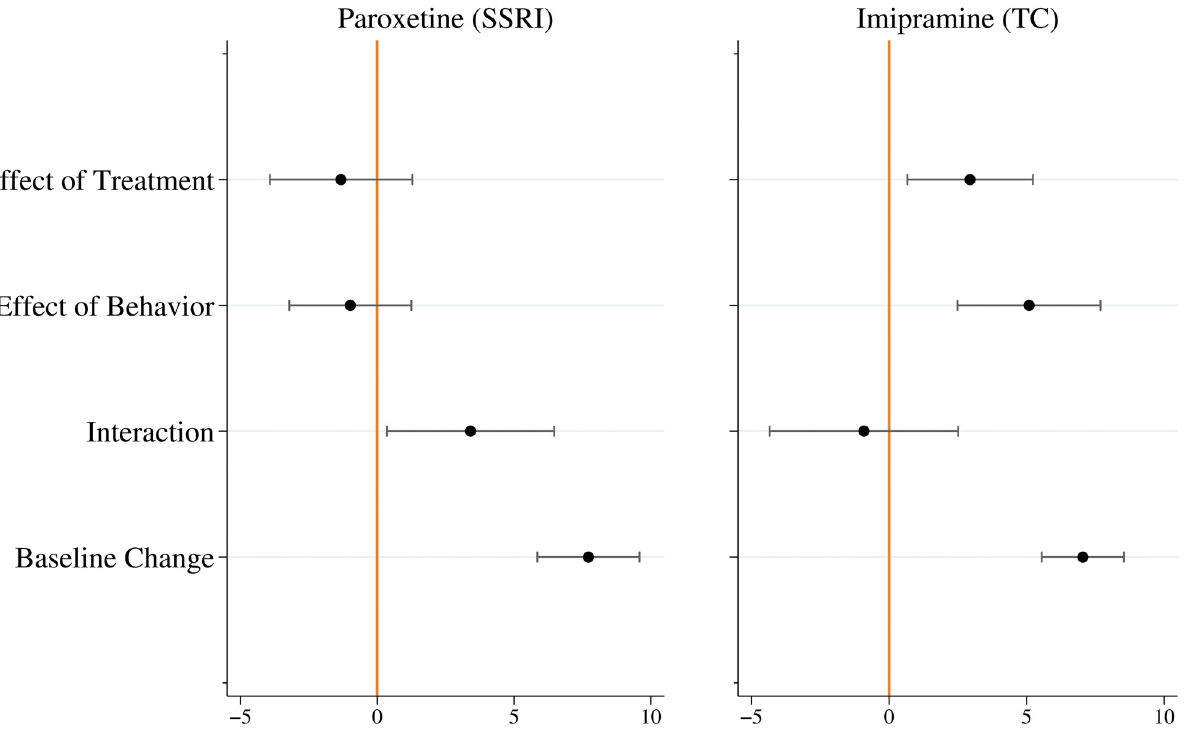
Fig 3. Behavior matters for both the SSRI and TC, but in different ways. The panels show the effect size (change in HDRS score) as point estimates (dots) and 95% confidence intervals centered at the point estimate constructed from hetero-skedastic consistent standard errors